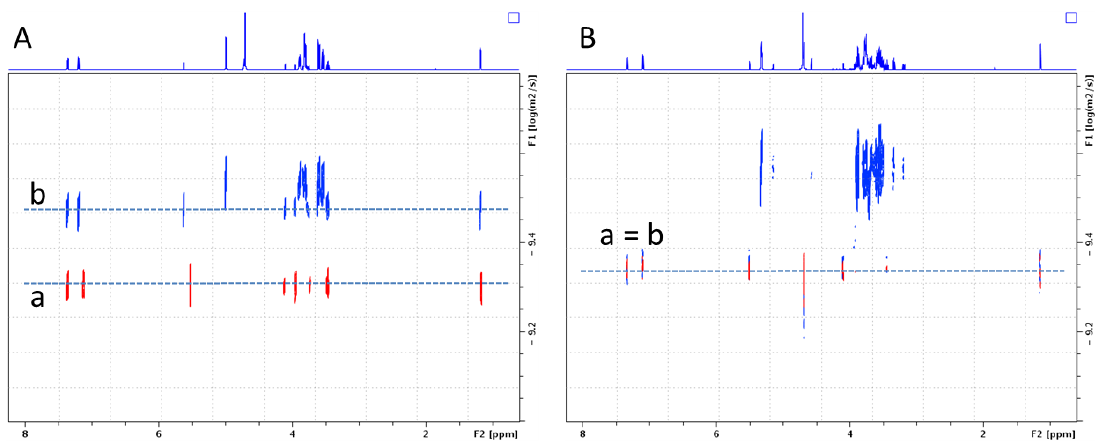
Figure 5. Superimposed NMR diffusion-ordered spectroscopy (DOSY) spectra recorded at 600 MHz (D 2 O, 300 K, 5 mM) of MOR ( A ) alone (red) and in the presence of α-CD (blue); ( B ) alone (red) and in the presence of maltohexaose (blue). Vertical scale: diffusion coefficient; horizontal scale: 1 H chemical shift. To confirm this result, mass spectrometry, widely used to highlight non-covalent interaction in the gas phase under native conditions, was considered